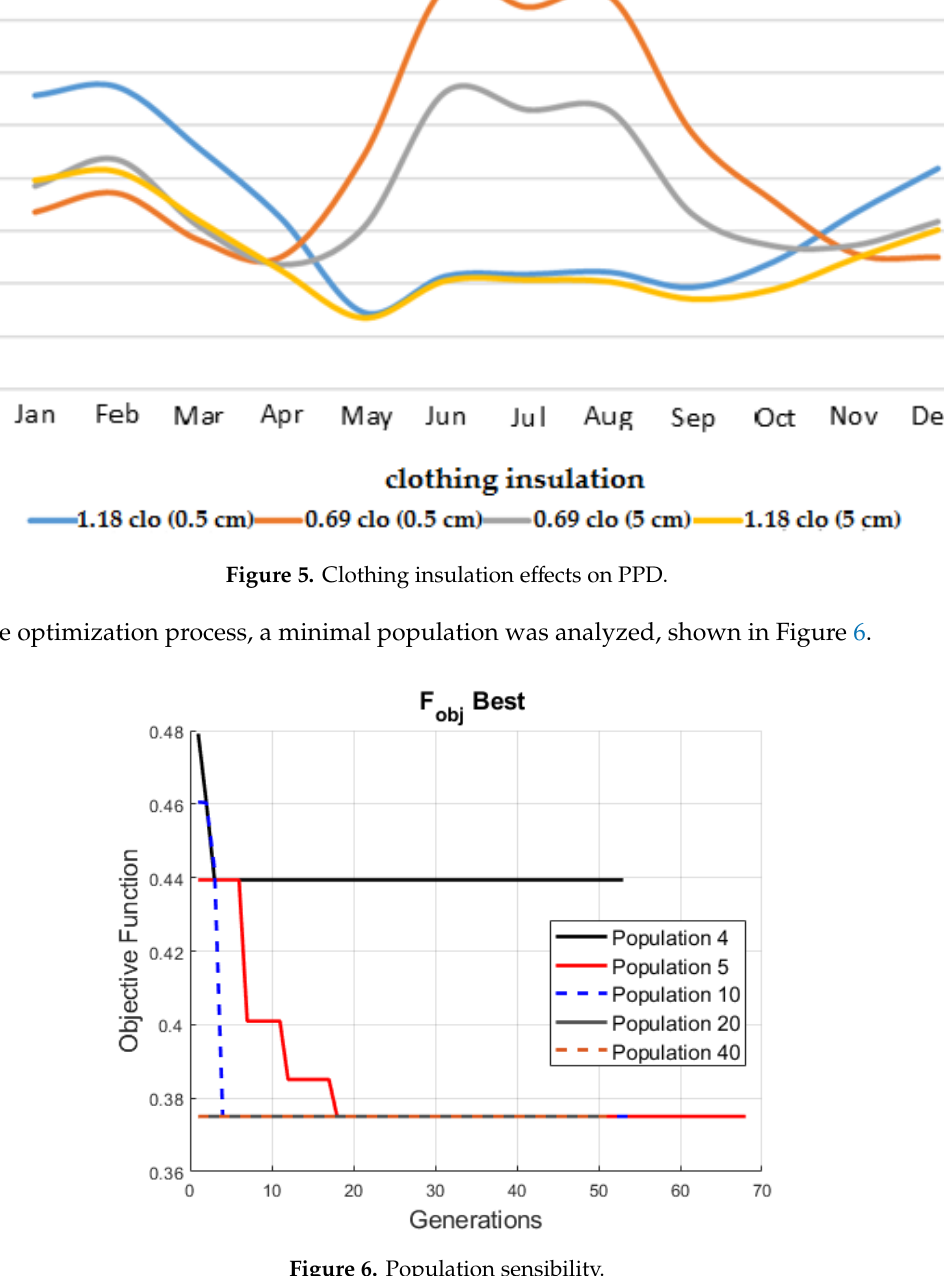
Figure 4. PPD (%) for 2 thicknesses of the PU insulation used on the roof in Recife, Brazil.